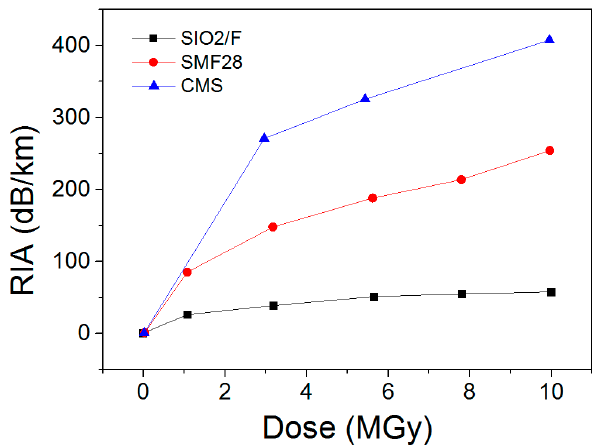
Figure 22. Measured RIA at 1.55 µm after different doses of irradiation from 1 to 10 MGy for three single-mode optical fibres: pure silica core fibre (SiO 2 /F), Telecom-grade germanosilicate (SMF28) and highly Ge-doped (CMS).